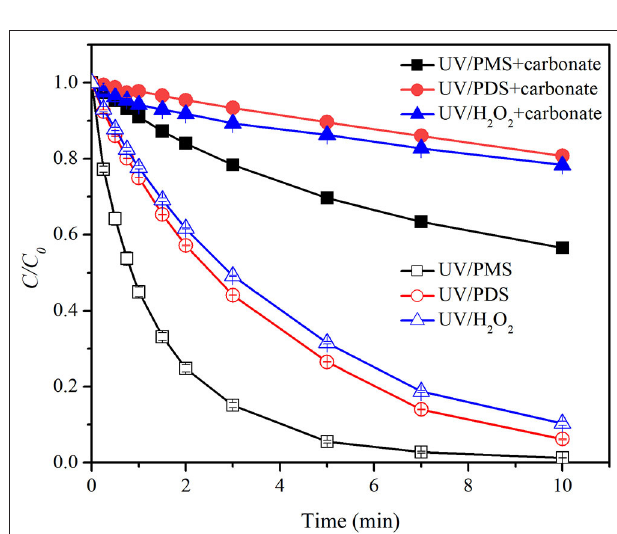
FIGURE 3 | Degradation efficiencies of BA by UV/PMS, UV/PDS, and UV/H 2 O 2 in the presence of carbonate. Conditions: 0.6L, I 0 = 1.7 × 10 − 6 Einsteins · s − 1 , [BA] = 9.0 µ M, [PMS] = 100 µ M as 1/2 Oxone, [H 2 O 2 ] =